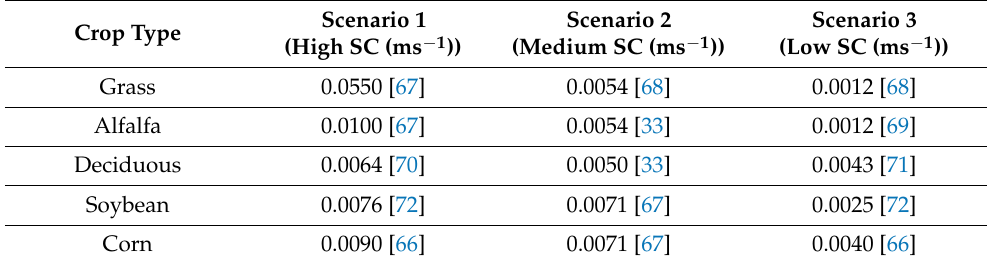
Table 4. Crop-specific stomatal conductance values used in the BEPS’ runs. SC—Stomatal conductance.